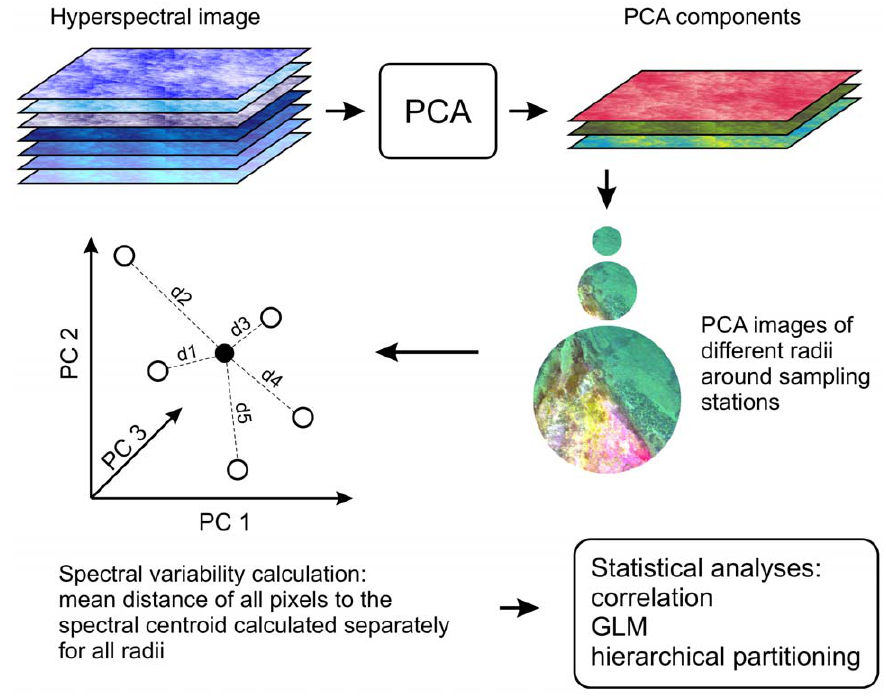
Figure 2. General flowchart of processing of the remotely sensed data.